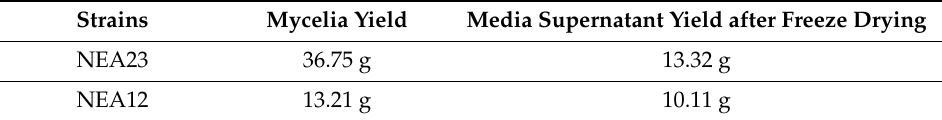
Table 5. Mycelia yield and media supernatant yield (after freeze drying) from 1 L PDB culture of NEA12 and